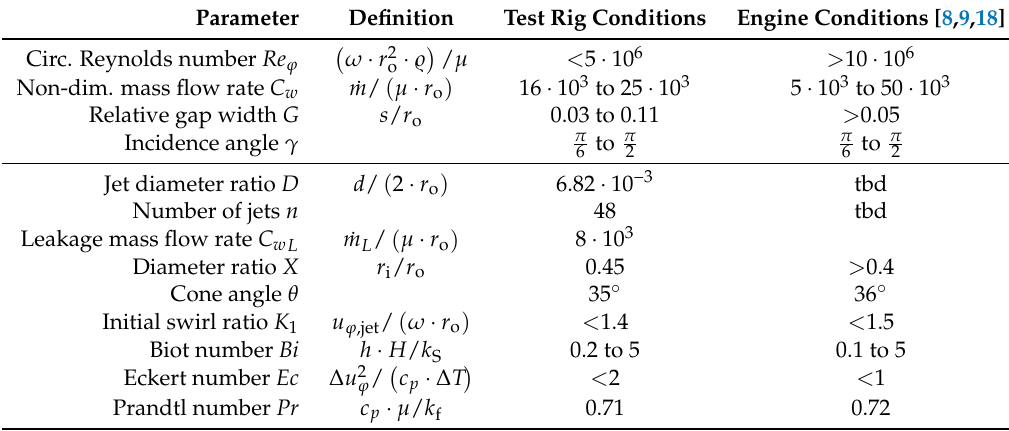
Figure 3. Geometric and thermodynamic parameters influencing the target parameter. Table 1. Variable and non-variable parameters and corresponding value